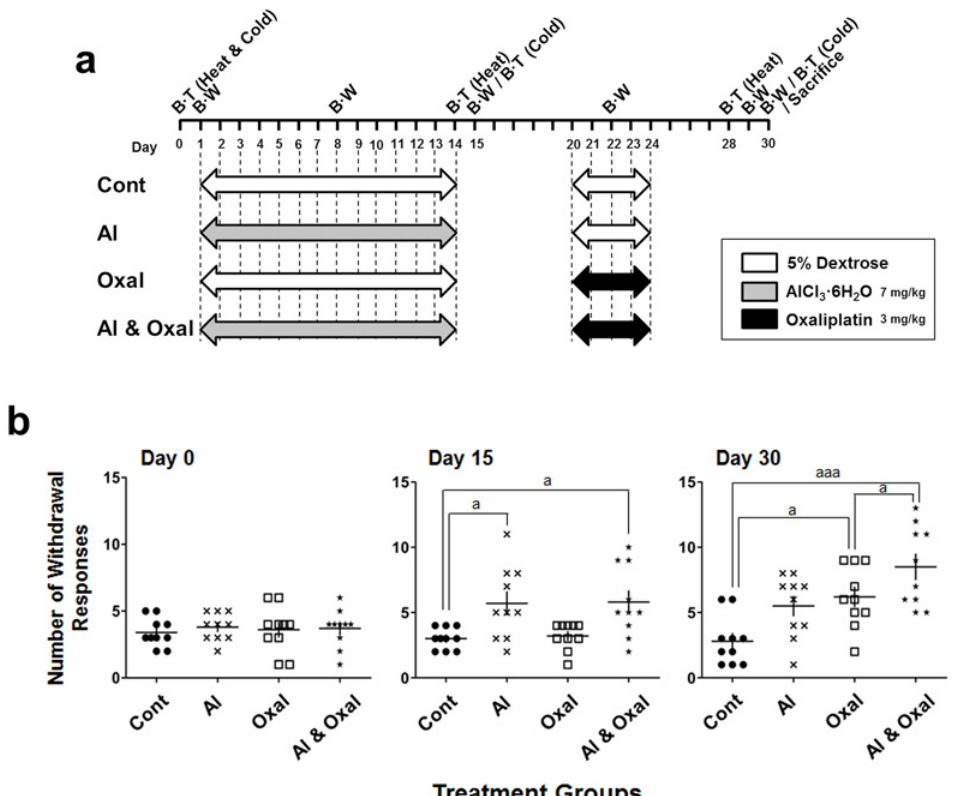
Fig 3. Exacerbation of peripheral neuropathy induced by combined treatment with oxaliplatin and aluminum chloride. 5% dextrose, aluminum chloride (AlCl 3 (cid:1) 6H 2 O, 7 mg/kg; equivalent 0.78 mg/kg of elemental Al), and oxaliplatin (3 mg/kg) were administered by i.p injection for 24 days including 5 days of rest. (a). Acetone test for cold allodynia was performed before the first infusion and then every 15 days (b). Hypersensitivity to cold stimuli was synergistically increased in mice treated with both oxaliplatin and aluminum chloride. Cont ( ● : 5% dextrose), Al (x: aluminum chloride, 7 mg/kg), Oxal ( □ : oxaliplatin, 3 mg/kg), Al & Oxal ( $ : aluminum chloride 7 mg/kg and oxaliplatin 3 mg/kg). Results are representative of two independent experiments. Values are expressed as the mean ± SEM ( n = 10 per group). a p < 0.05, aaa p < 0.001 compared with the control or oxaliplatin group. BT: behavioral test, BW: